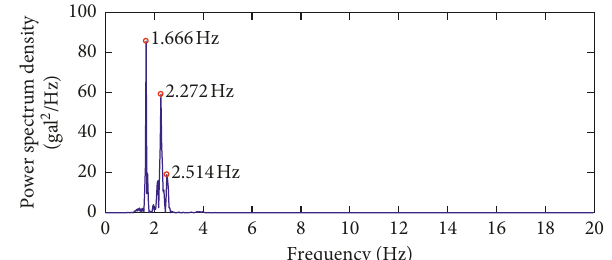
Figure 17: Spectrum diagram of the signal after EEMD-Wavelet- SSA